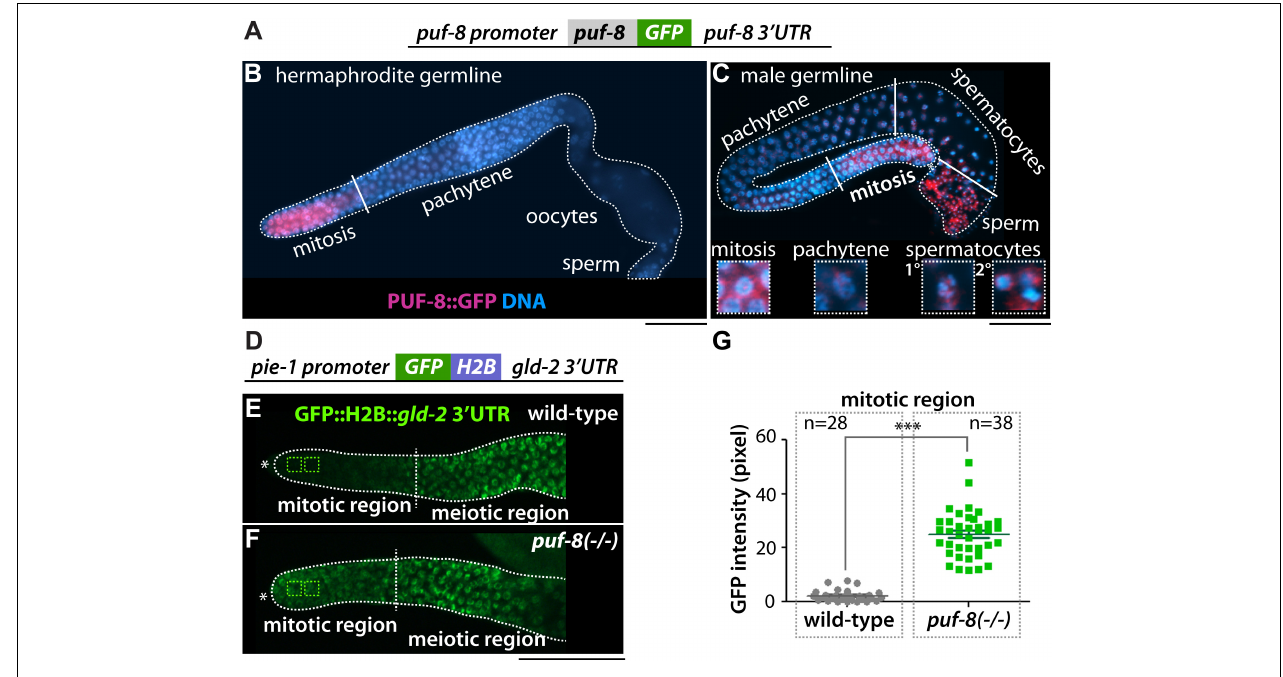
FIGURE 3 | PUF-8 represses the expression of gld-2 in the distal germline. (A) The design of the PUF-8:GFP fusion. (B,C) PUF-8:GFP expression in adult hermaphrodite and male germlines. (D) The design of the gld-2 3 (cid:48) UTR fusion. The pie-1 promoter is permissive for expression in all germ cells. (E,F) Staining